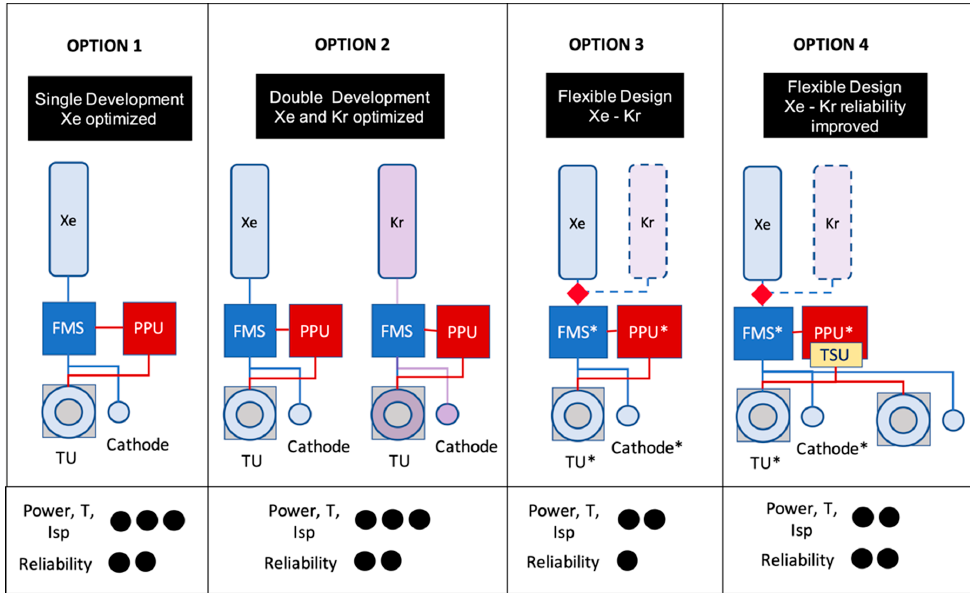
Figure 4. Alternatives to embed flexibility in an EP architecture, in the case of change of type of propellant. Please note that Option 3 represents the case of a single string propulsion system that could mount a xenon tank or a krypton tank. This is symbolized by a red rhombus. Also, the asterisk (*) represents components that are sub-optimized (e.g., reduced efficiency) in order to enable flexibility.